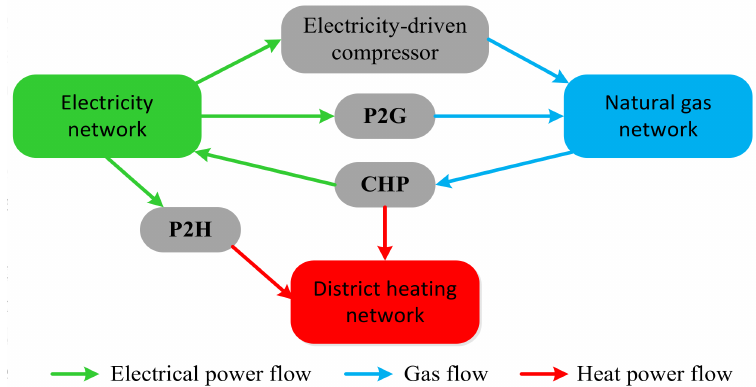
Figure 1. Schematic diagrams of the EGH-IES.